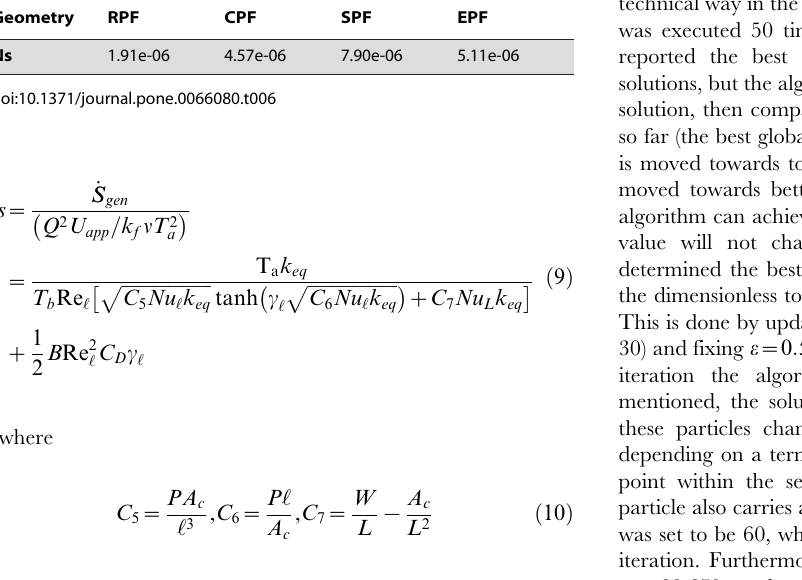
Table 6. The values of NS with e ~ 0 : 5 .